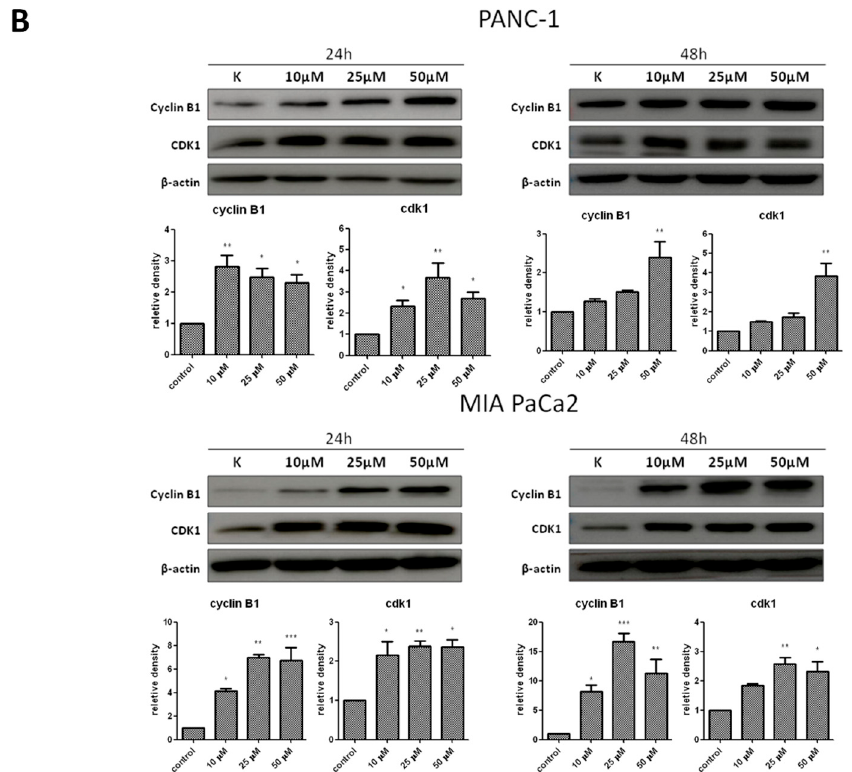
Figure 6. The cell cycle analysis of PANC-1, MIA PaCa2 and hTERT-HPNE cells treated with vanadium complex T1 after 24 h and 48 h of incubation. ( A ) The percentage of cells in each phase. ( B ) Western blot of cyclinB1 and cdk1 expression in cancer cells. Results are given as mean ± SD of 3 separate determinations. * p < 0.05; ** p < 0.01; *** p < 0.001, as compared with untreated cells.